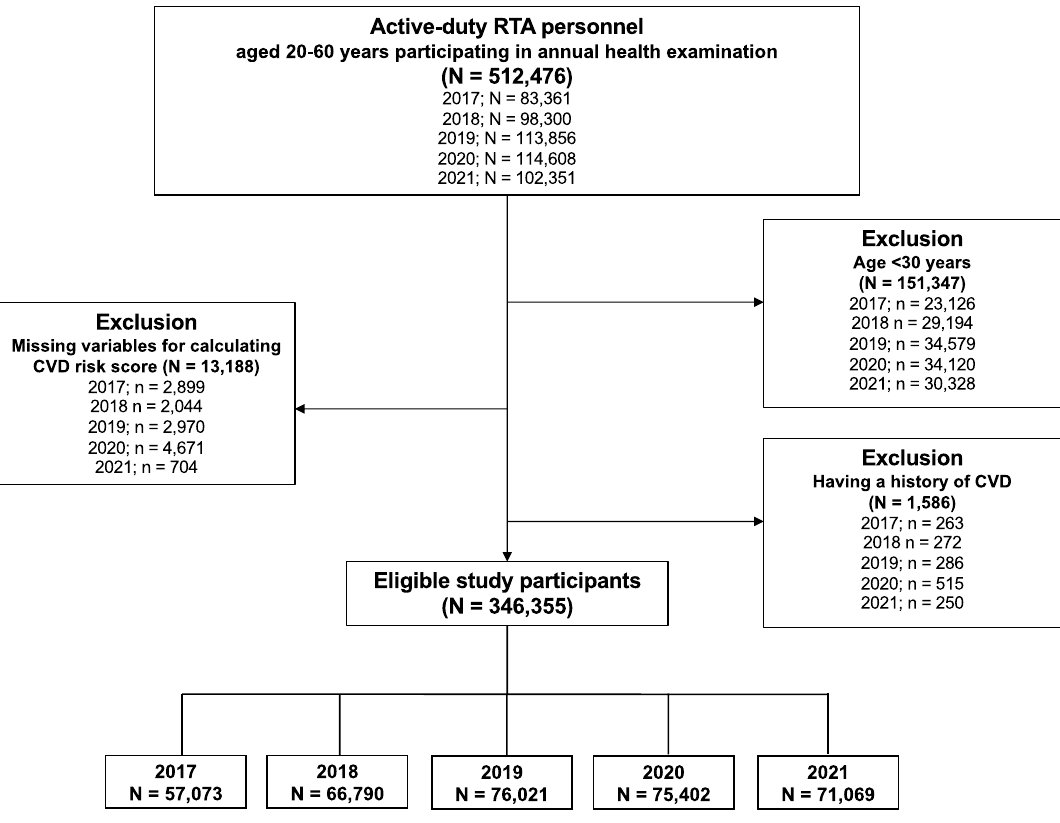
Figure 1. Flowchart of the